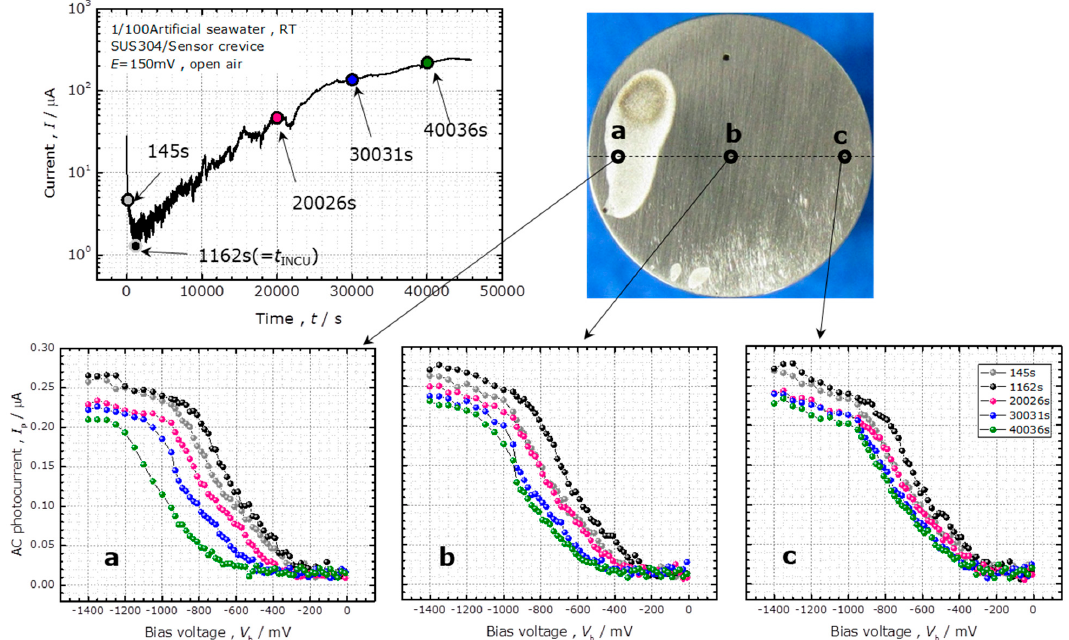
Figure 2. ( Top left ) The temporal change of the corrosion current during the potentiostatic test of a SUS304 specimen at E = 150 mV in 1 / 100 ASW. ( Top right ) Optical photograph of the corroded surface after 48,132 s of the corrosion test. (Bottom) I–V curves measured at different points a, b, and c .